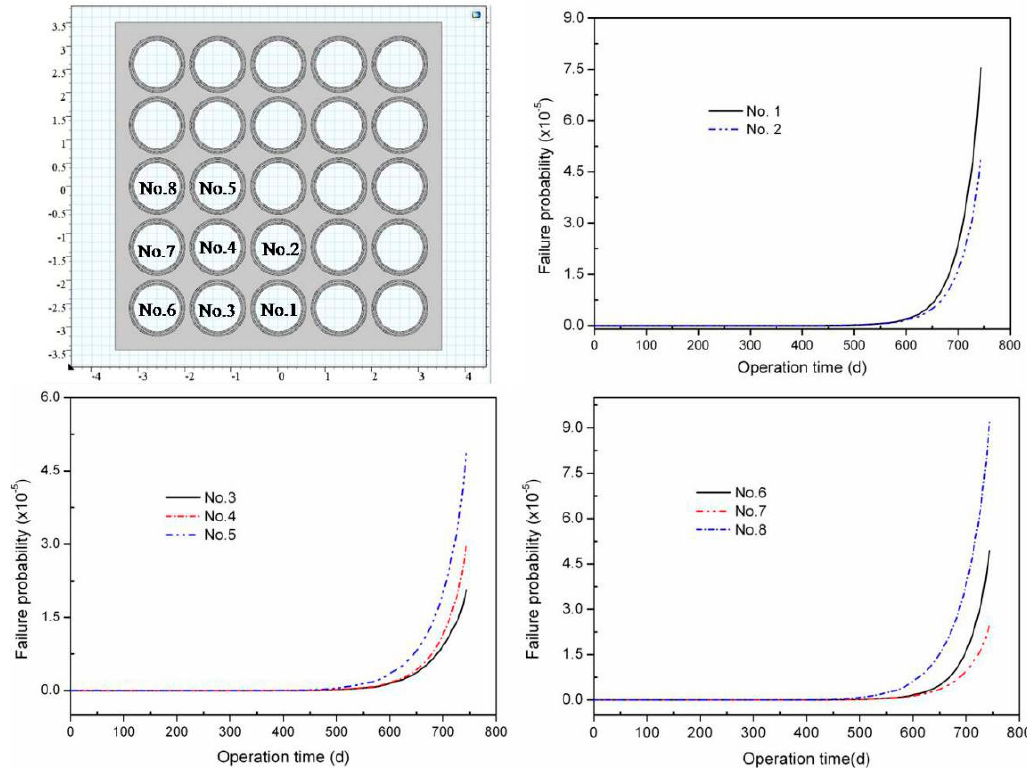
Figure 11. Failure probability of the SiC layers located in different parts of the FCM pellet.